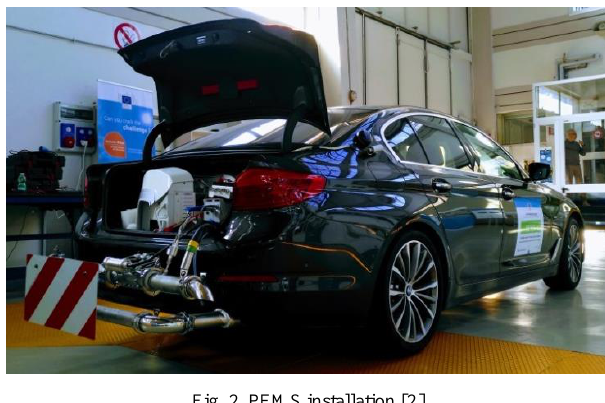
Fig. 2. PEMS installation [2]